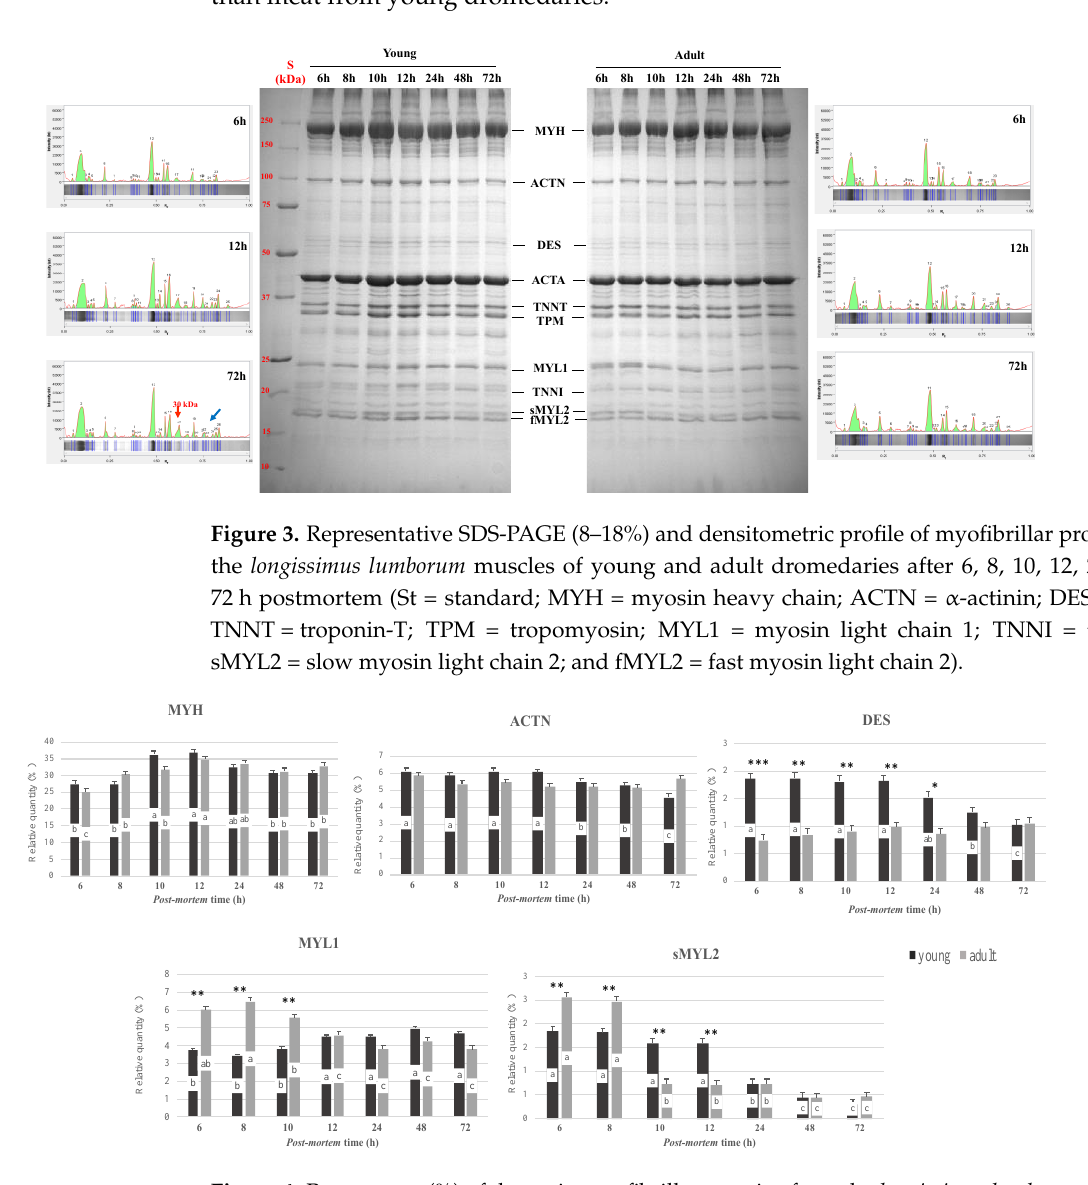
Figure 4. Percentages (%) of the main myofibrillar proteins from the longissimus lumborum muscles of young and adult dromedaries after 6, 8, 10, 12, 24, 48 and 72 h postmortem (MYH = myosin heavy chain; ACTN = α -actinin; DES = desmin; MYL1 = myosin light chain 1; sMYL2 = slow myosin light chain 2; ∗ = p < 0.05; ∗∗ = p < 0.01; ∗∗∗ = p < 0.001 slaughter age effect; a – c = p < 0.05 , postmortem time effect; and means ± SEM).